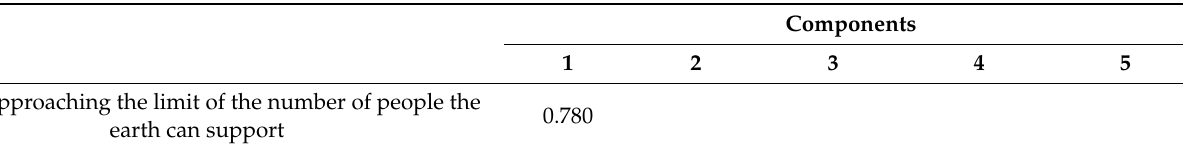
Table A1. NEP scale’s